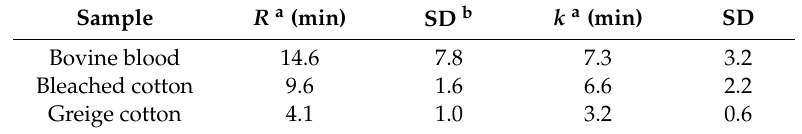
Table 1. Clotting activity of bleached 100% nonwoven cotton versus 100% greige cotton.